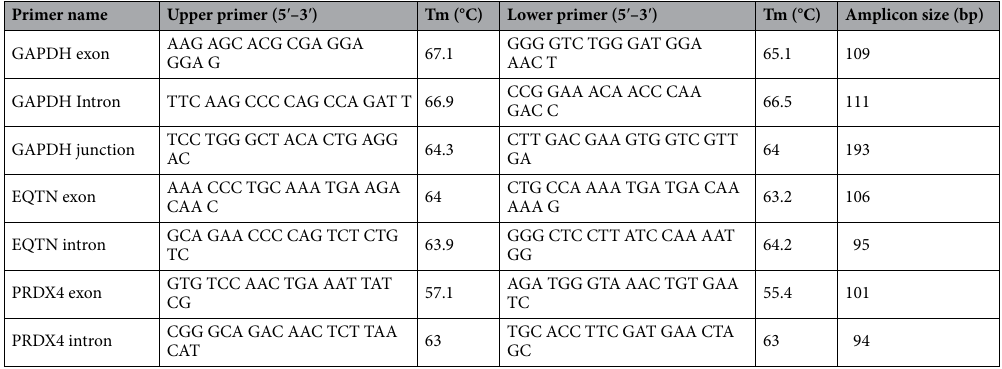
sample was placed on pre-heated (37 °C) Makler counting chamber (Sefi Medical Instruments, Haifa, Israel). Under a phase contrast microscope, the motility, hyperactivation, curvilinear velocity, straight line velocity, aver- age path velocity, linearity, beat cross frequency, wobble, and mean amplitude of head lateral displacement of spermatozoa were measured (Supplementary Table S1 online) 32 . RnA isolation and cDnA synthesis. Sperm RNAs were isolated by using a PureLink RNA Mini Kit (Inv- itrogen) according to the manufacturer’s protocol with some modifications. Briefly, spermatozoa pellets were resuspended in PBS and counted under microscope with a Makler counting chamber to adjust the concentration to 40–50 × 10 6 cells/mL. Pellets (40–50 × 10 6 cells) were suspended in non-toxic guanidine-isothiocyanate lysis buffer in PureLink RNA Mini Kit containing β-mercaptoethanol (40 μL/mL; Sigma-Aldrich Co) and homog- enized. TRIzol (Invitrogen) and chloroform were added and centrifuged at 12,000 × g . The upper layer was transferred into a fresh tube and mixed with pure ethanol (supernatant : pure ethanol = 1:1, v/v; Sigma-Aldrich Co). Sperm RNA was attached to a spin cartridge. For DNase-treated RNA, the spin cartridge membrane was incubated in PureLink DNase mixture (80 µL; Invitrogen) for 15 min at room temperature during washing. Both isolated RNAs with and without DNase were immersed in 20 μL of nuclease-free water. The quality (260/280 ratio) and quantity of sperm RNA were checked with an Epoch Microplate Spectrophotometer (BioTek, Win- ooski, VT, USA). After matching of total RNA concentration among samples (total 400 ng), cDNA was syn- thesized with the PrimeScript 1st strand cDNA Synthesis Kit (Takara Bio, Inc., Shiga, Japan) according to the manufacturer’s protocol. Oligo dT and random hexamer primers were compared for cDNA synthesis. Rt‑qpcR. The cDNA was mixed with SYBR Green PCR master mix (Applied Biosystems, Foster city, CA, USA) and amplified on a 7,500 fast real-time PCR system (Applied Biosystems). As a positive control and negative control, cDNA from porcine testis RNA and no template and reverse transcriptase cDNA was used, respectively. All primers were designed based on Reference genome Sscrofa11.1 Primary Assembly. For method optimization, we compared the exon, intron, and exon-exon junction primers of GAPDH, a reference gene for RT-qPCR in boar spermatozoa (Table 2) 63 . The EQTN and PRDX4 genes were selected as target markers of male fertility 37,39 . Exon and intron primers of selected markers were designed; and for reference gene, GAPDH was used (Table 2). The amplification efficiency of primers was tested with calibration curve 64 . Briefly, the cDNA was diluted into 1, 2.5, 5, 10, and 25X (250, 100, 50, 25, and 10 ng) in each well and Cq value of studied genes were analyzed with amount of cDNA (Supplementary Fig. S5 online). The total reaction volume was 20 µL (100 ng of cDNA). The cycling parameters were 95 °C (10 min) followed by 40 cycles at 95 °C (15 s) and 60 °C (60 s). After cycling, continuous melt curve analysis was performed at 95 °C (15 s), 60 °C (60 s), and a progressive increase up to 95 °C (0.5 °C/30 s). Data were analyzed with the 7,500 Software v2.3 (Thermo Fisher Scientific, Waltham, MA, USA). Relative expression of each gene was calculated with delta delta Cq method and to consider the gDNA factor with intron expression, a calculation from Laurell et al. was used 59 .